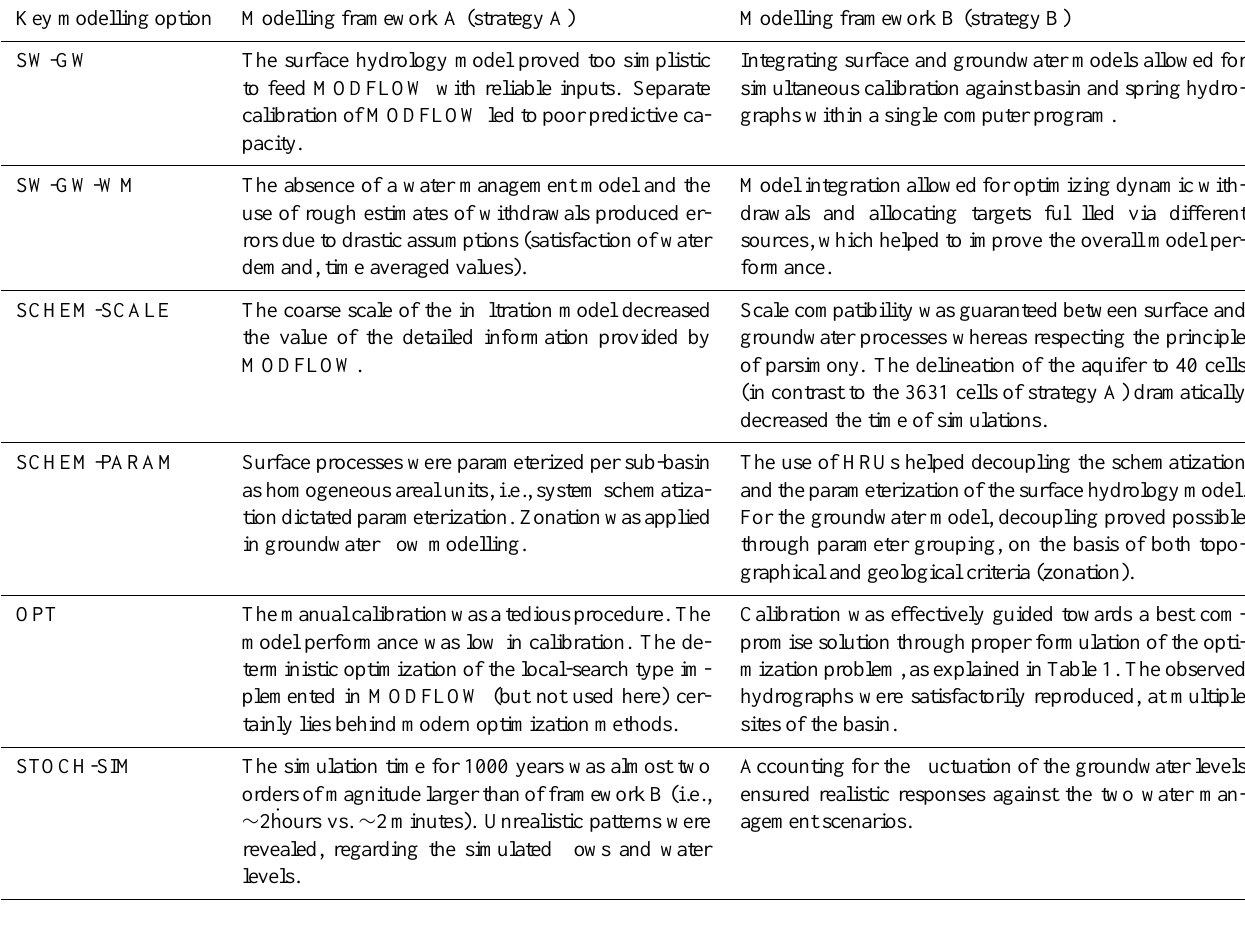
Table 4. Key points related to the effectiveness of the alternative modelling frameworks as reflected in the research results of this work.